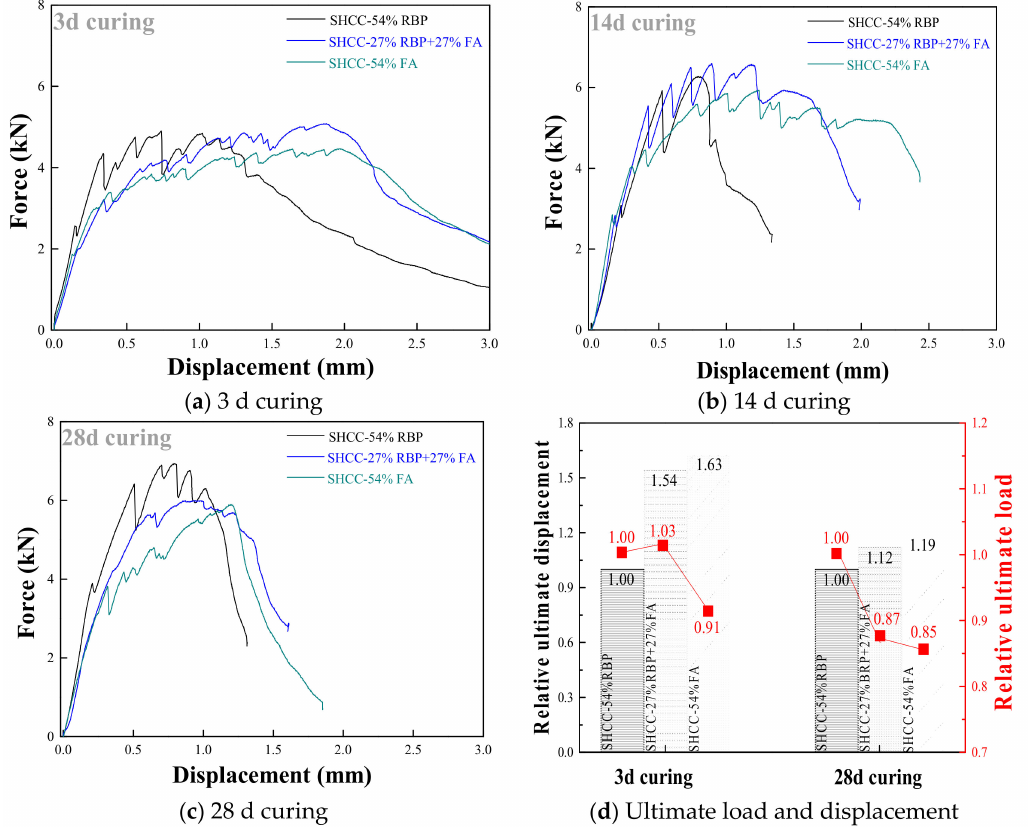
Figure 15. Force-displacement curves of SHCC when replacing FA with various RBP